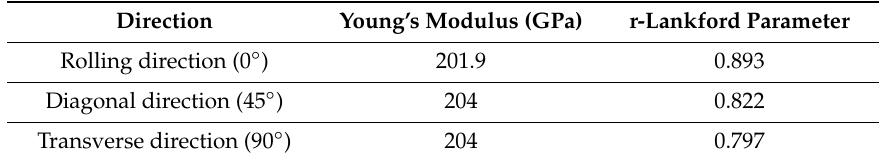
Table 2. Uniaxial tensile properties of